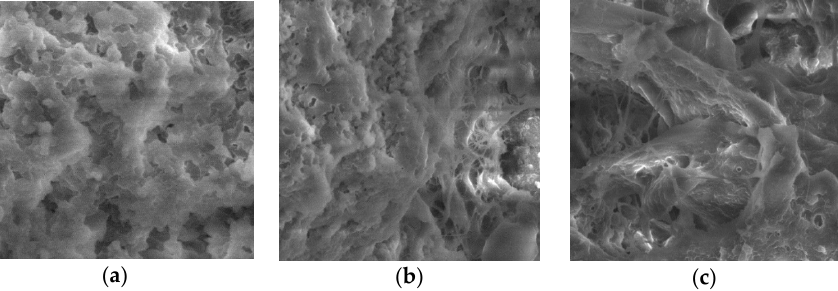
Figure 4. SEM micrographs of yogurt without ( a ) and with 4.5% of CP added after ( b ) and before ( c ) fermentation. ( c )